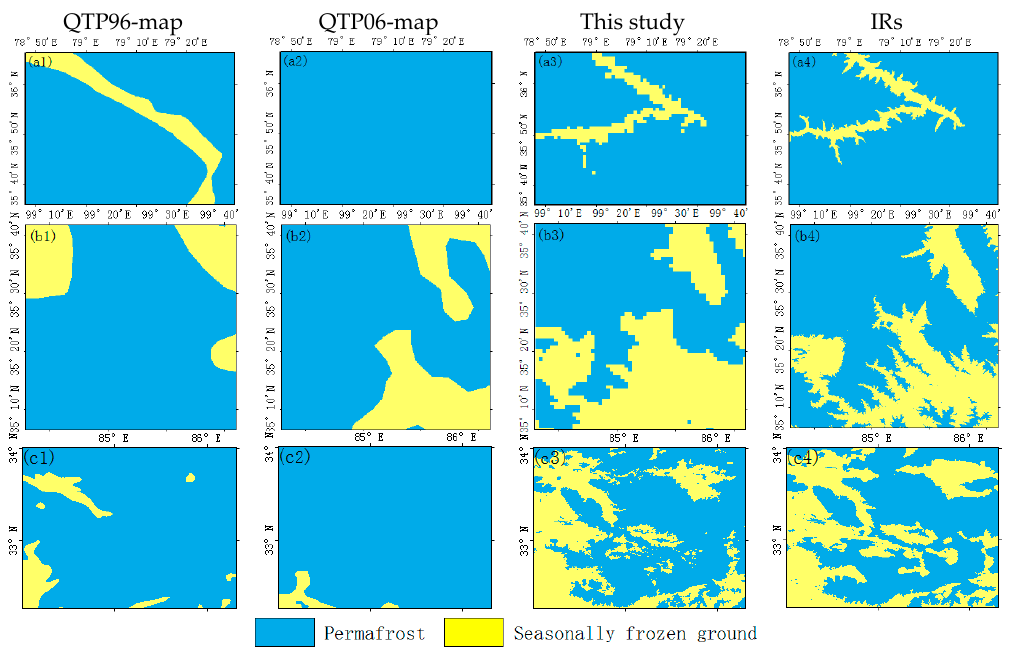
Figure 9. Permafrost distribution of the three investigated regions: West Kunlun ( the first row ), Wenquan ( the second row ), Gaize ( the last row